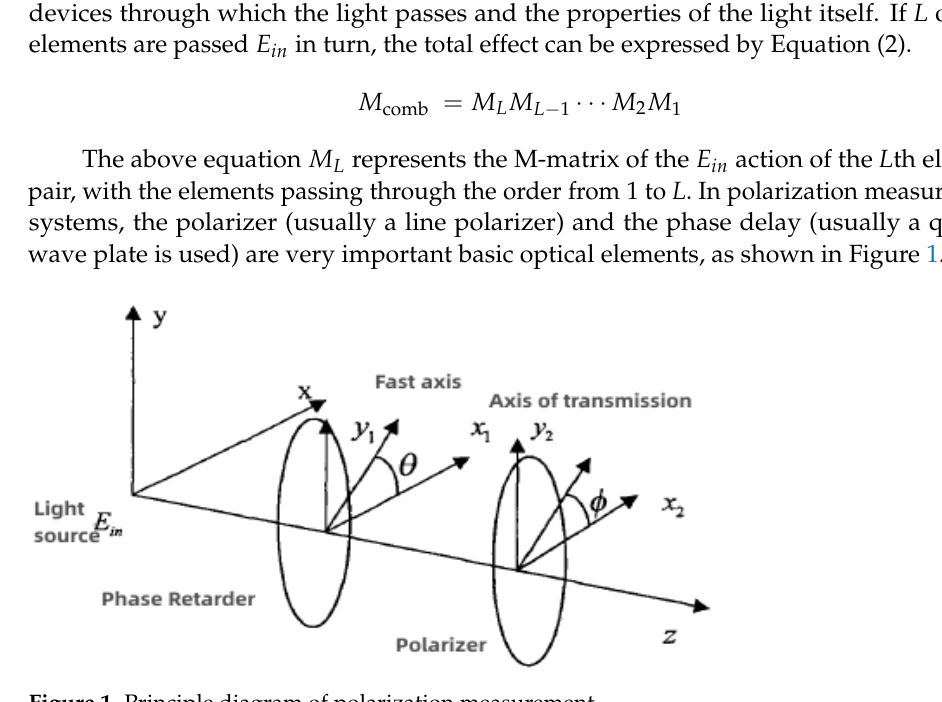
Figure 1. Principle diagram of polarization measurement. A beam of light propagates E in along the Z-axis direction and passes through the phase delayers (the fast-axis direction is at an angle θ to the X-axis direction) and a line polarizer (the polarization direction is at an angle ϕ to the X-axis) in turn. The Stokes parameters can be obtained by rotating the phase delayers and polarizers, and this rotational measurement parameter method is highlighted below. Through the above introduction, we know that the Stokes vector has four basic parameters, and to solve them completely, at least four equations are needed. If a quarter wavelet (a kind of phase delay) and a line polarizer are placed on the measurement line, where when the direction of the fast axis of the quarter wavelet is at an angle to the X- axis, the M matrix of the wavelet can be expressed by Equation (3). can be expressed in Equa- tion (5), which I indicates the total intensity of the light, the intensity Q difference be- tween the horizontal (X-axis) polarization and the vertical (Y-axis) polarization, the inten- sity U difference between 45 degrees and 135 degrees in the direction of the polarized part of the light, and the intensity V difference between the left and right circular com- ponents of the light.